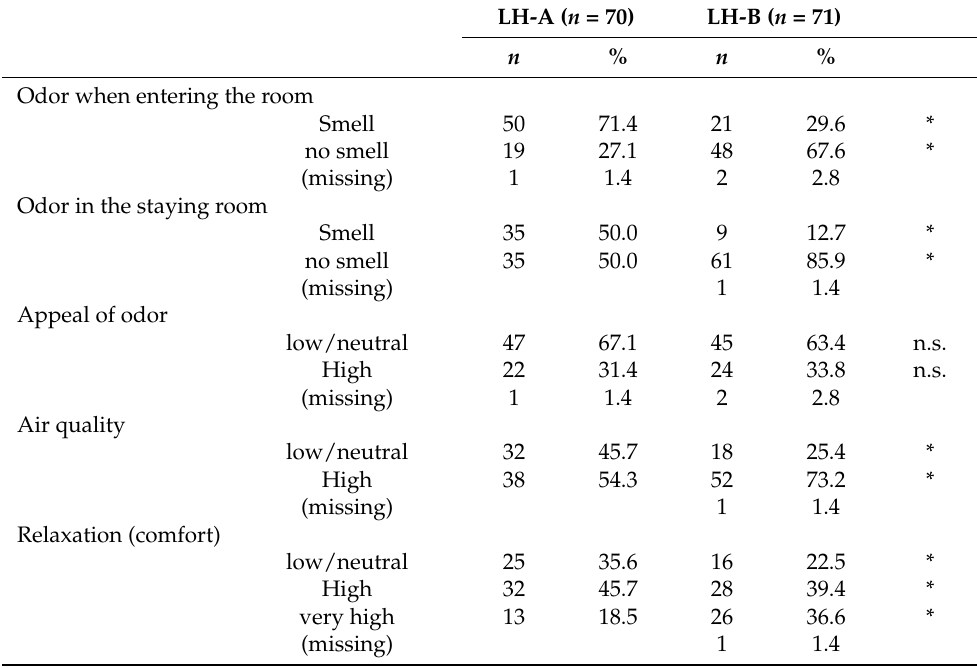
Table 2. Indoor-air characteristics in the laboratory houses evaluated in the questionnaire study ( n = 141).